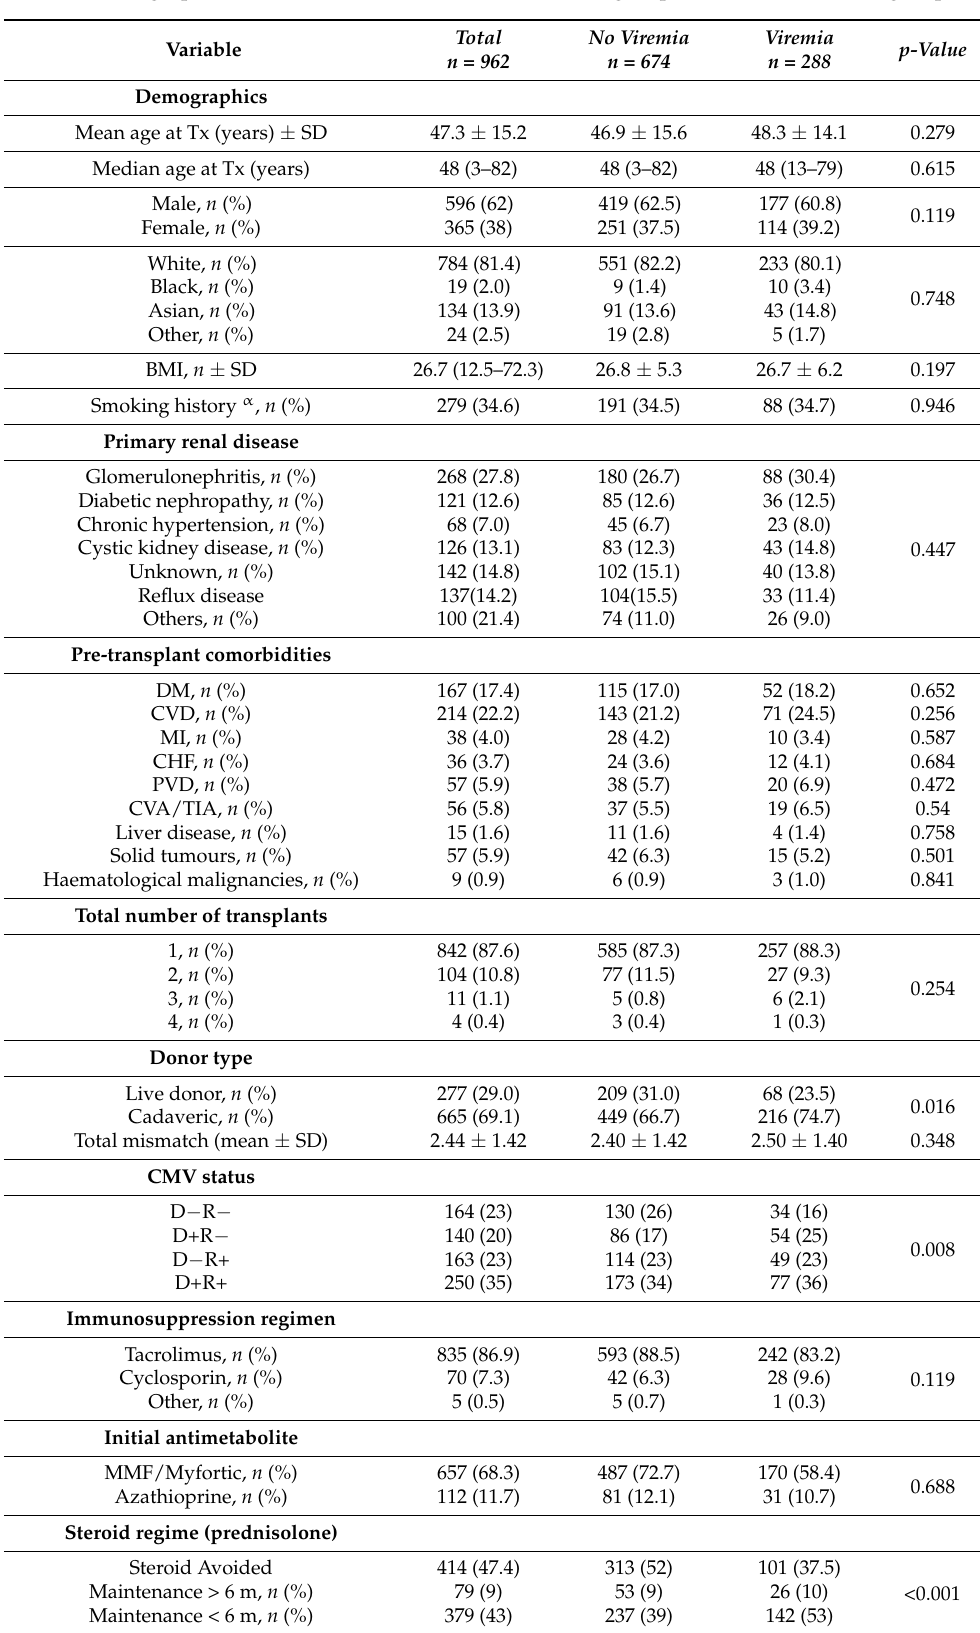
Table 1. Demographic and clinical characteristics of infection group vs. the non-infection